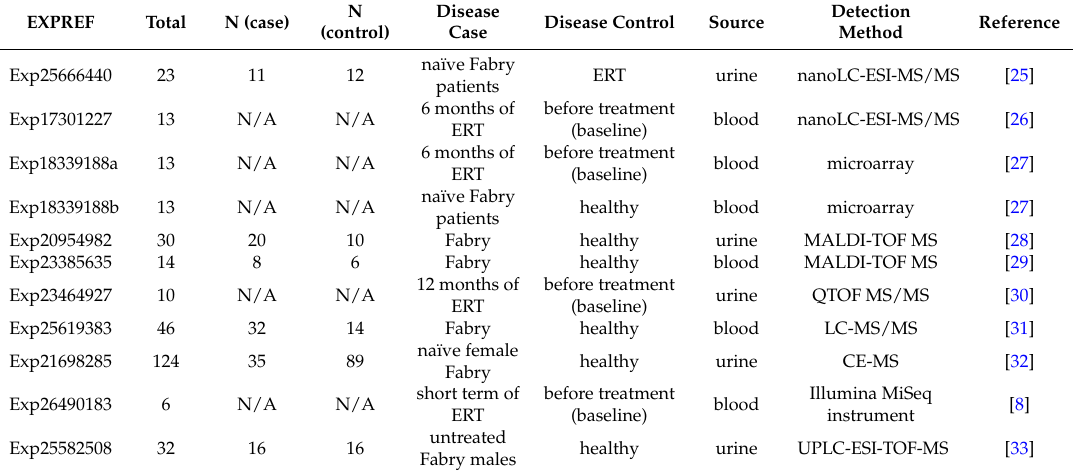
Table 1. Description of data sources used in this meta-analysis for both FD-naïve and ERT groups. EXPREF IDs contain PubMed IDs derived from the publication where data originated from. N/A: not